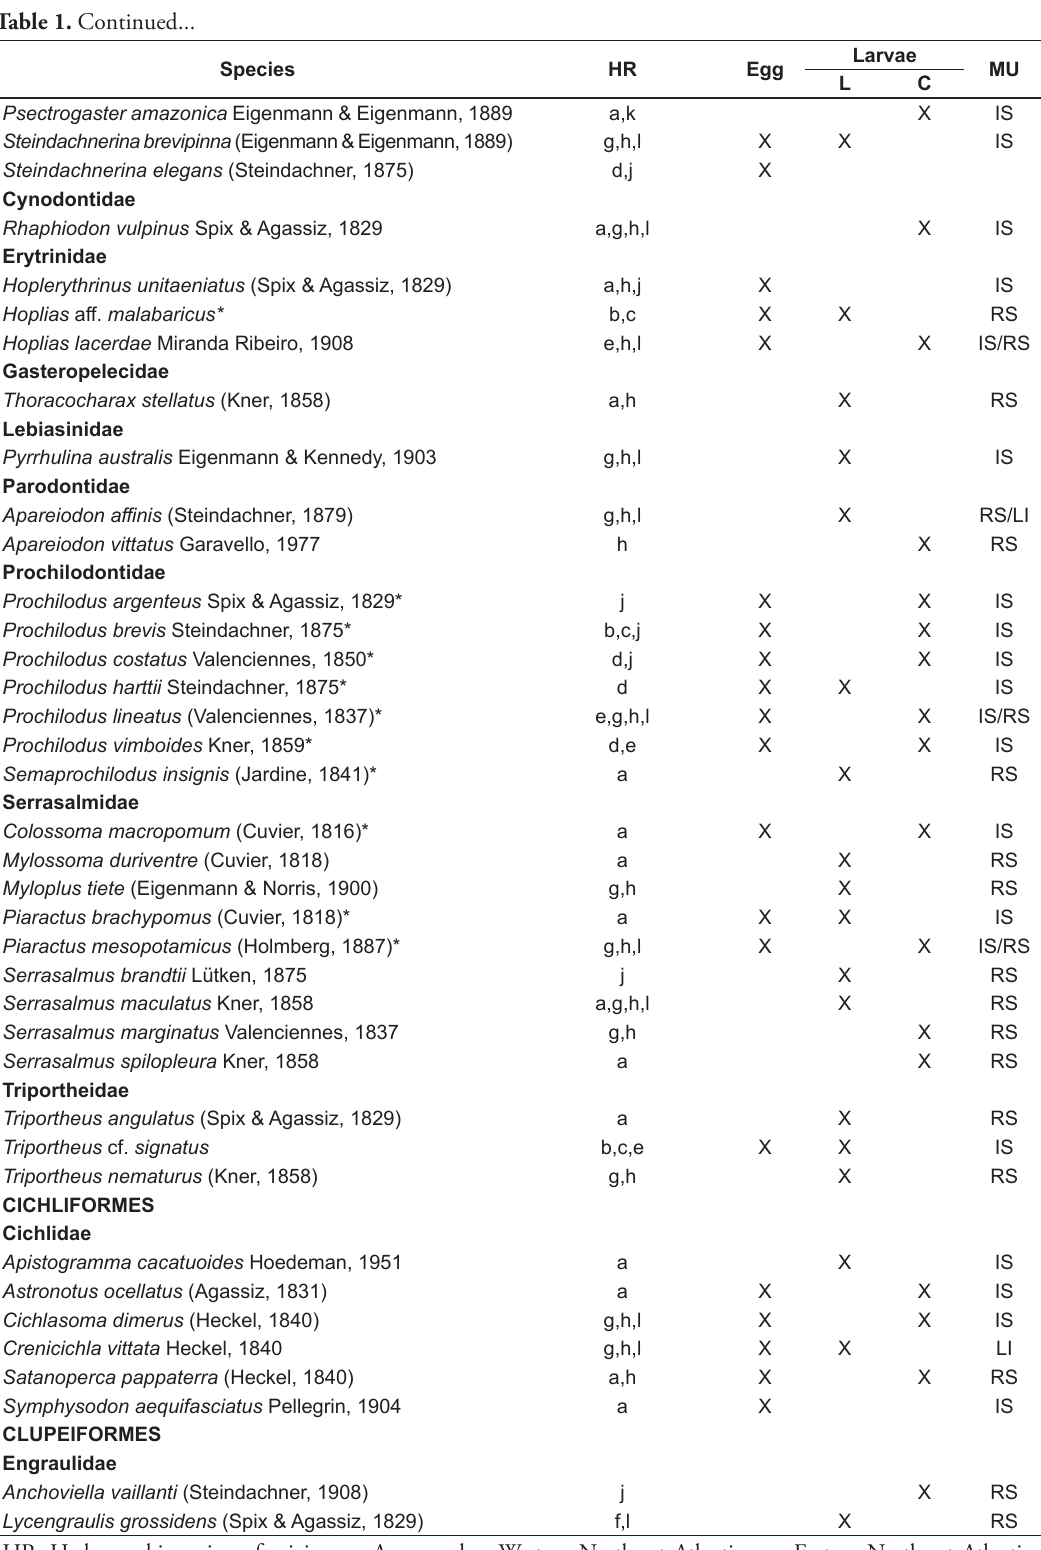
HR: Hydrographic region of origin, a = Amazon, b = Western Northeast Atlantic, c = Eastern Northeast Atlantic, d = East Atlantic, e = Southeast Atlantic, f = South Atlantic, g = Paraguay, h = Paraná, i = Parnaíba, j = São Francisco, k = Tocantins-Araguaia and i = Uruguay; Larvae, I = Incomplete, without all larval stages and C = Complete, with all larval stages; MU = Methodology used to obtain the collection, RS = regressive series, IS = induced spawning and LI = live ichthyoplankton *commercial